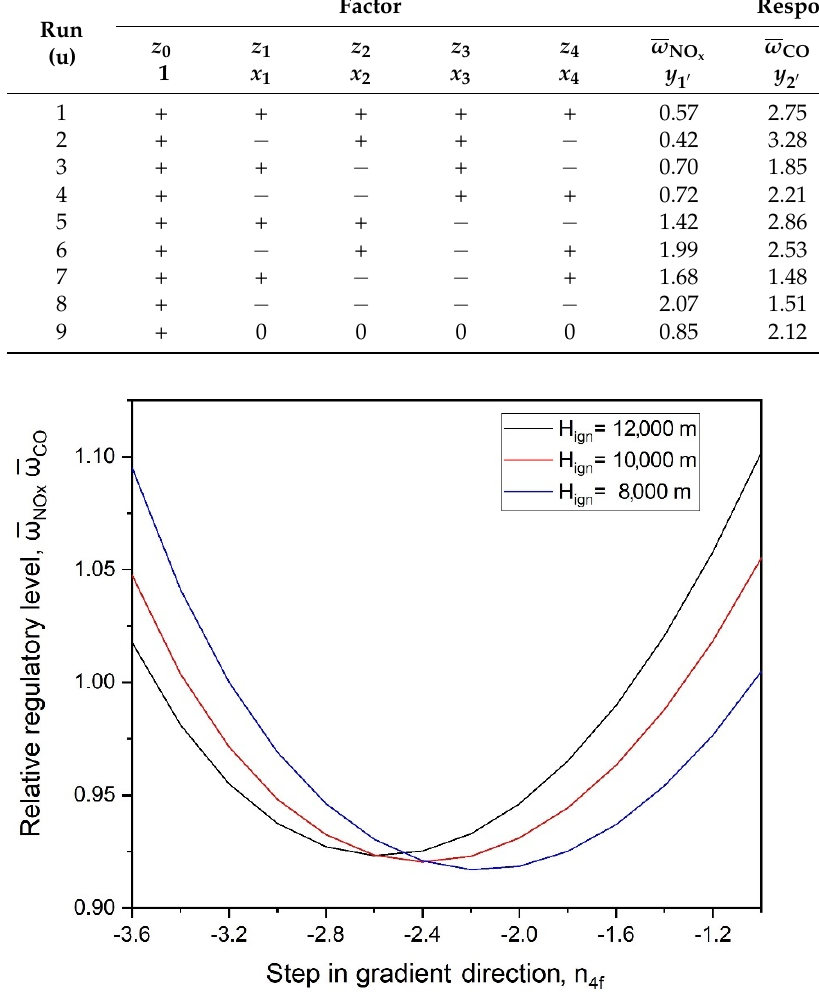
Figure 8. Relative regulatory level ( ω NO ω CO ) based on step in gradient direction for four factors. (cid:2033)(cid:3365) (cid:2887)(cid:2899) ) based on step in gradient direction for four factors. Figure 8. Relative regulatory level ( (cid:2033)(cid:3365) (cid:2898)(cid:2899) x (cid:3182) Table 7. Results of optimization Table 6. Fractional factorial design and experimental results involving four factors.